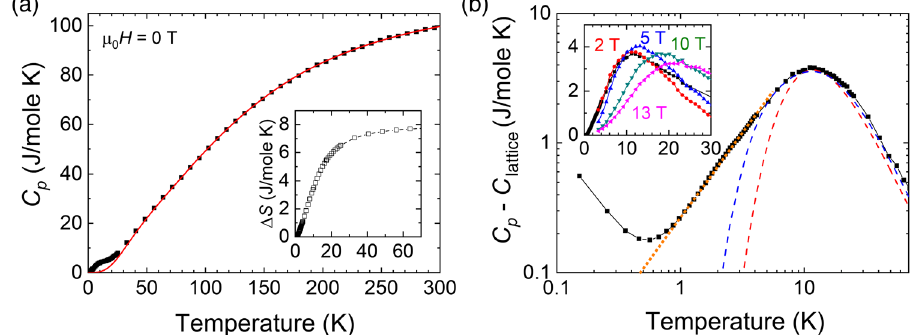
ð T Þ for polycrystalline TbInO FIG. 4. (a) C 3 . The red line denotes the lattice contribution described in the text. The inset shows the p =T versus T curve above 1 K. (b) The C magnetic entropy ( Δ S ) acquired by integrating the C curve in the log-log scale. Red and blue res res dashed lines are a fit to the Schottky model described in the text. The orange dotted linear line is a guide to the eye that follows a power law T 1 . 25 . The inset shows the field-dependent